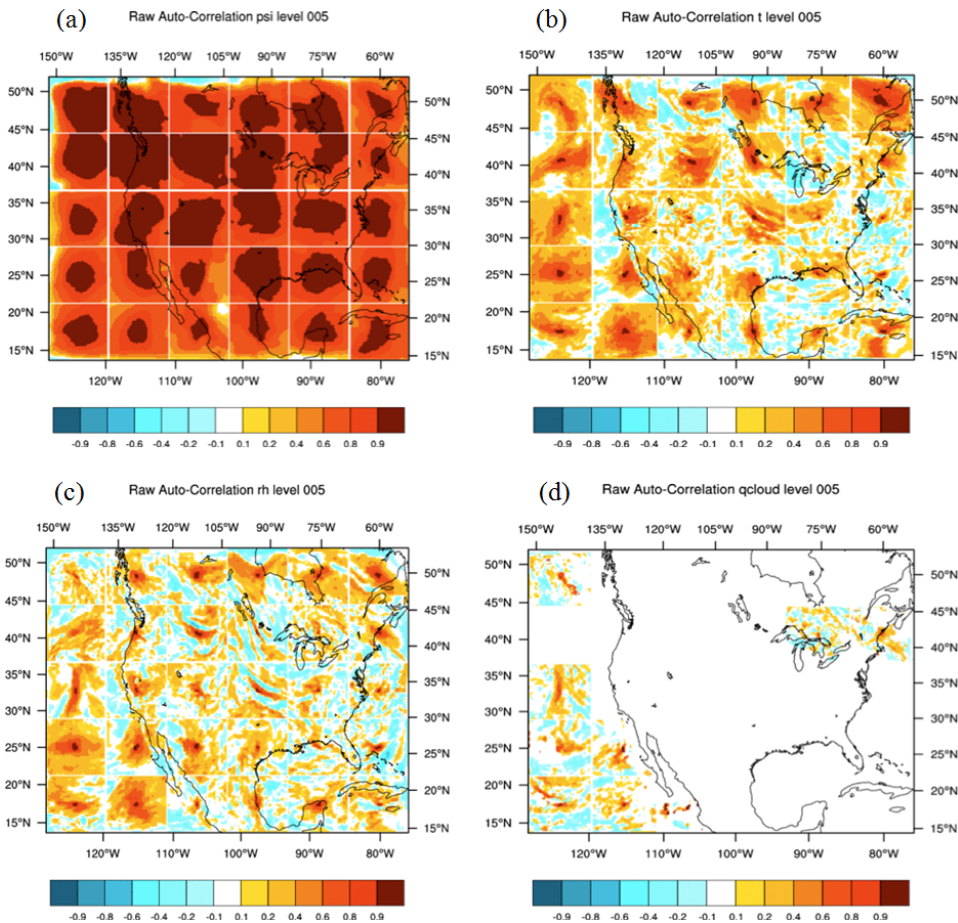
Figure 5. Horizontal autocorrelation performed at the center of each square grid over vertical model level 5, around 950hPa, for control variables (a) stream function (psi), (b) temperature ( t ), (c) relative humidity (RH), and (d) cloud mixing ratio ( q cloud ) . Larger correlations are observed for stream function compared to temperature and relative humidity. Cloud mixing ratio has the smallest correlation due to theinhomogeneous distribution of hydrometeors (WRF, res. 15km,